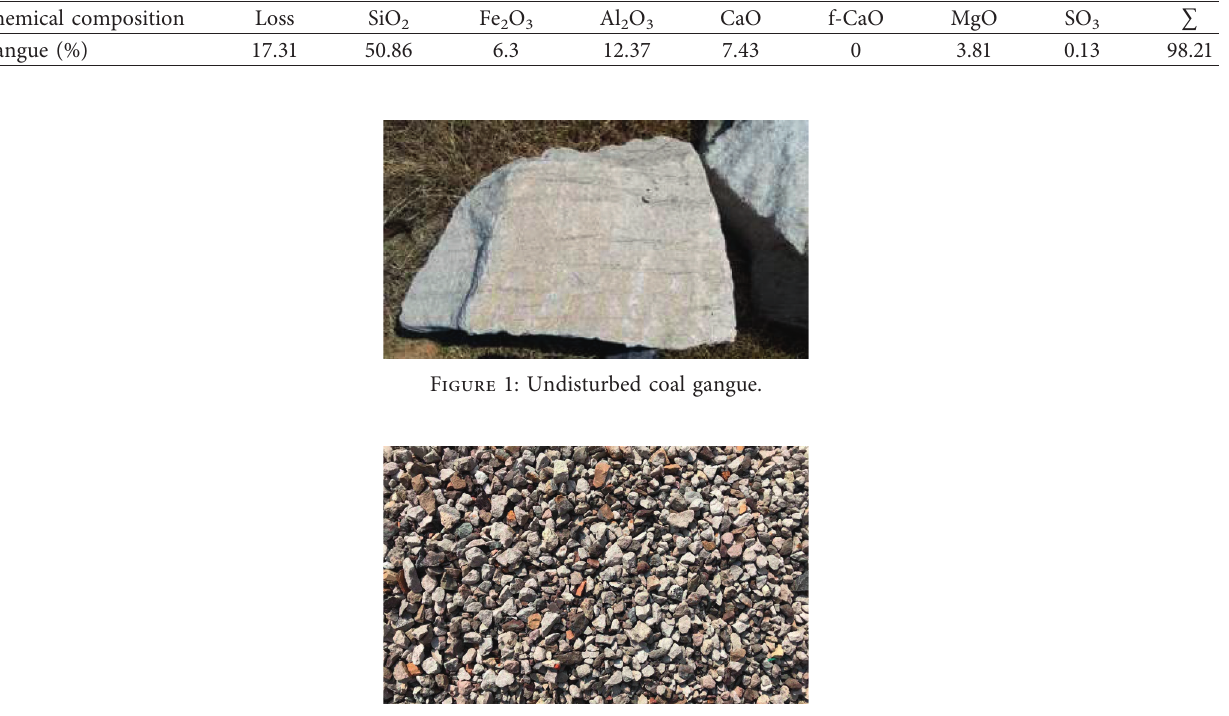
Figure 2: Coal gangue coarse aggregate. Table 3: Test reference mix ratio.